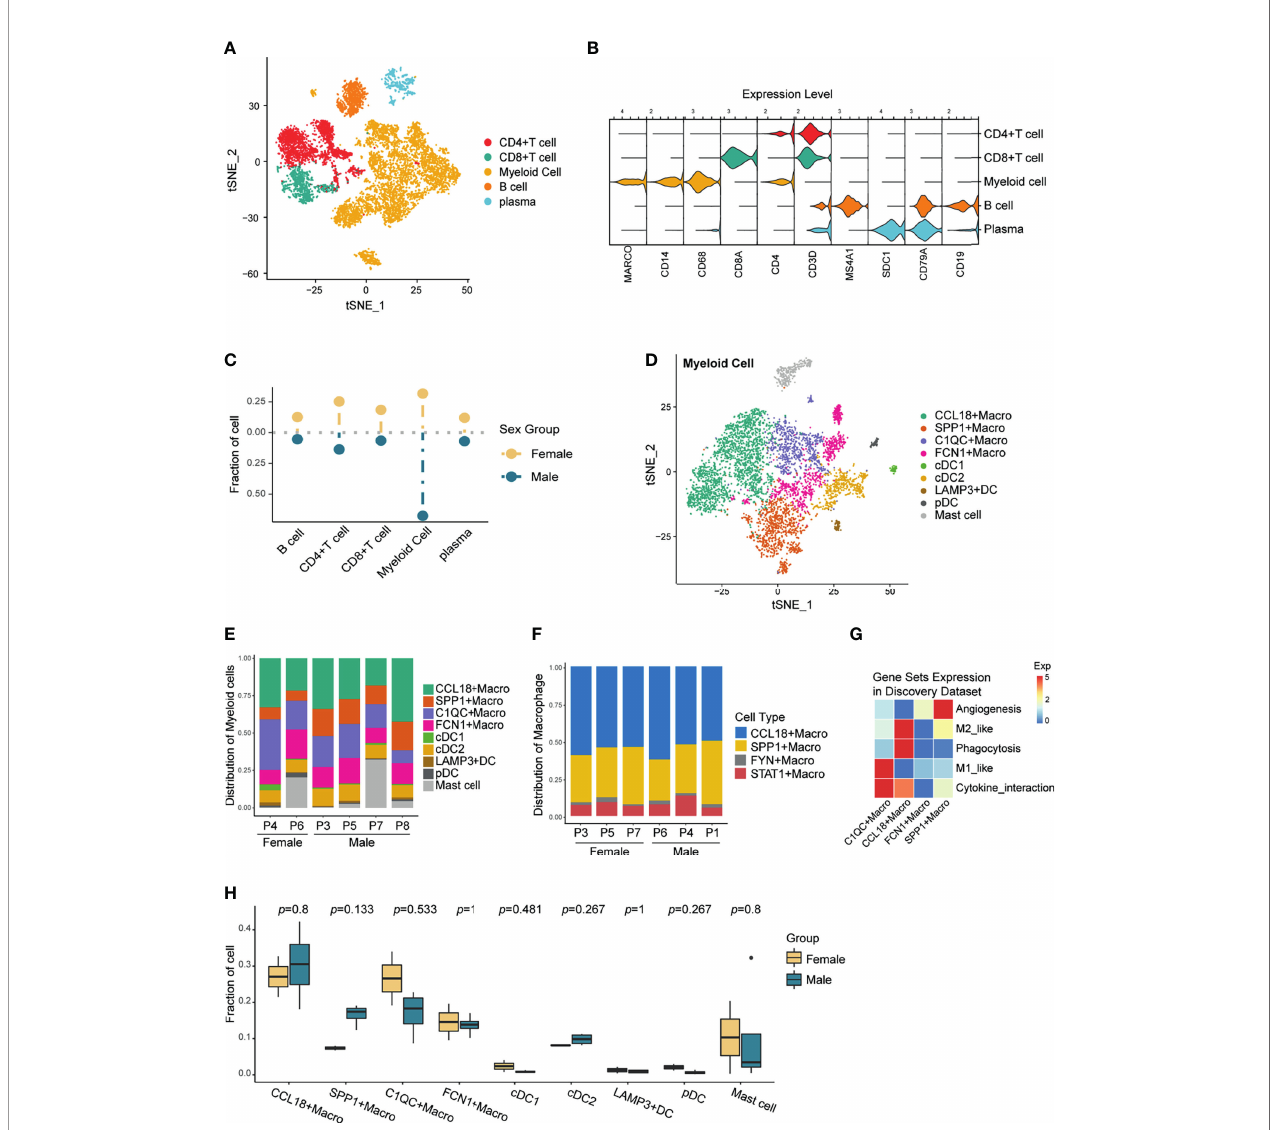
FIGURE 2 | Re-clustering of Immune Cells and Preliminary Exploration of Myeloid Cells. (A) t-SNE plot of the tumor-in fi ltrating immune cells. (B) Violin plot showing the relative expression of immune cell-type-speci fi c markers in each immune cluster. (C) Lollipop plot showing the fraction of immune cells in male and female, colored by sex. Unpaired Wilcoxon test showed no statistical differences between sexes. (D) A t-SNE plot of the tumor-in fi ltrating myeloid cells. (E) The composition of myeloid clusters in patients from the discovery scRNA-seq data. (F) Composition of the TAMs in patients from the validation scRNA-seq data 1. (G) Heatmap showing the relative expression of selective gene sets across all TAM subtypes in the discovery data. (H) Boxplot showing the comparison of Myeloid cell fraction between sexes in the discovery data. P -values were calculated by the unpaired two-sided Wilcoxon test. No signi fi cantly differently expressed myeloid cell types were